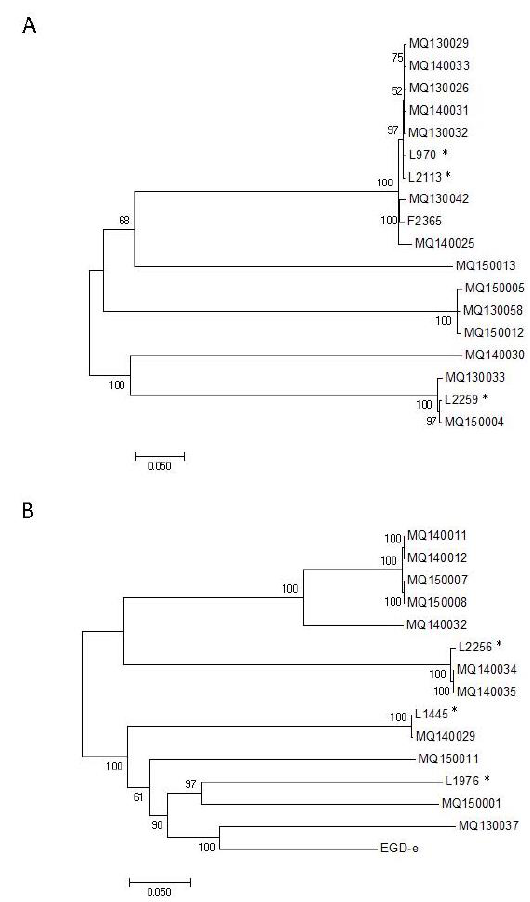
Figure 2. Phylogeny of the isolates as determined by single nucleotide polymorphism (SNP) analysis. ( A ) All serotype 4b isolates were compared with strain F2365 as the reference genome. The evolutionary history was inferred by using the Maximum Likelihood method based on the General Time Reversible model [34]. The tree with the highest log likelihood ( − 67933.7374) is shown. The percentage of trees in which the associated taxa clustered together is shown next to the branches. Initial tree(s) for the heuristic search were obtained automatically by applying Neighbor-Join and BioNJ algorithms to a matrix of pairwise distances estimated using the Maximum Composite Likelihood (MCL) approach, and then selecting the topology with superior log likelihood value. The tree is drawn to scale, with branch lengths measured in the number of substitutions per site. The analysis involved 18 nucleotide sequences. Codon positions included were 1st + 2nd + 3rd + Noncoding. All positions with less than 95% site coverage were eliminated. That is, fewer than 5% alignment gaps, missing data, and ambiguous bases were allowed at any position. There were a total of 12,069 positions in the final dataset. Evolutionary analyses were conducted in MEGA7 [31]. ( B ) All serotype 1/2a isolates were compared with strain EGDe as the reference genome. The evolutionary history was inferred by using the Maximum Likelihood method based on the General Time Reversible model [34]. The tree with the highest log likelihood ( − 214301.5165) is shown. The tree is drawn to scale, with branch lengths measured in the number of substitutions per site. The analysis involved 15 nucleotide sequences. Codon positions included were 1st + 2nd + 3rd + Noncoding. All positions with less than 95% site coverage were eliminated. That is, fewer than 5% alignment gaps, missing data, and ambiguous bases were allowed at any position. There were a total of 30,102 positions in the final dataset. Evolutionary analyses were conducted in MEGA7 [31]. * Indicates strains from a food production